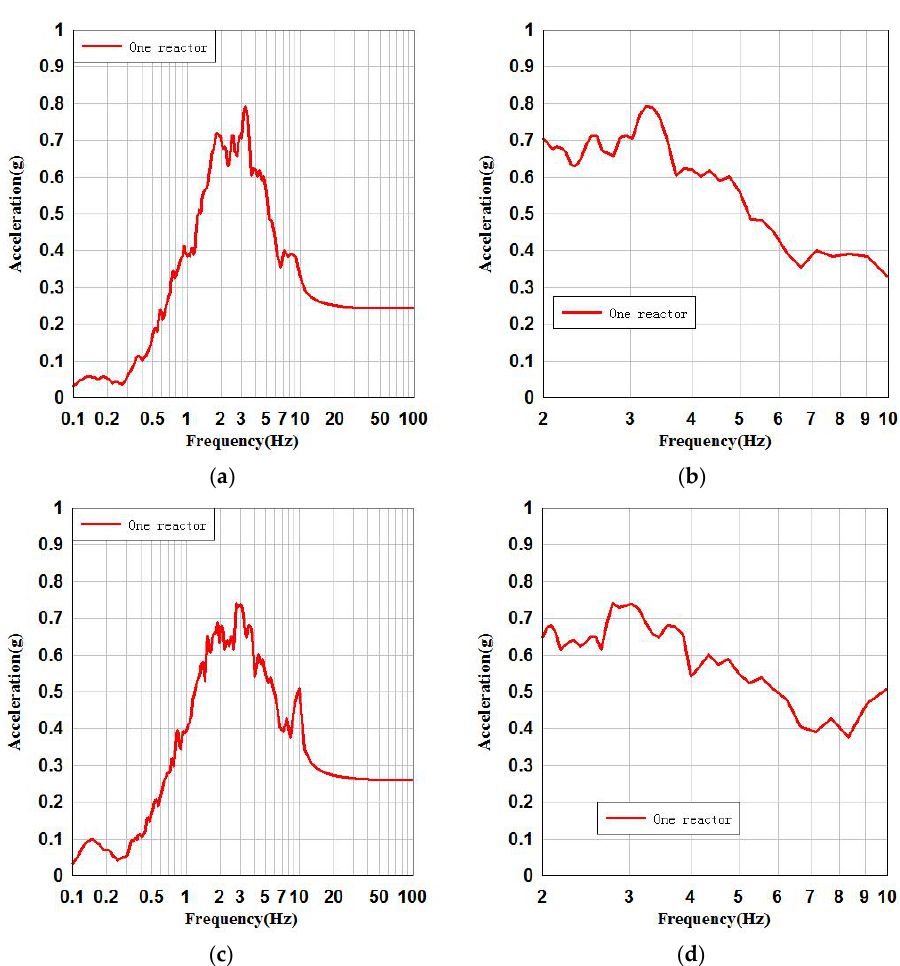
Figure 5. FRS of the raft foundation reference point in x and y directions. ( a ) FRS of the raft foundation in the x direction. ( b ) FRS of the raft foundation in the x direction (2–10 Hz). ( c ) FRS of the